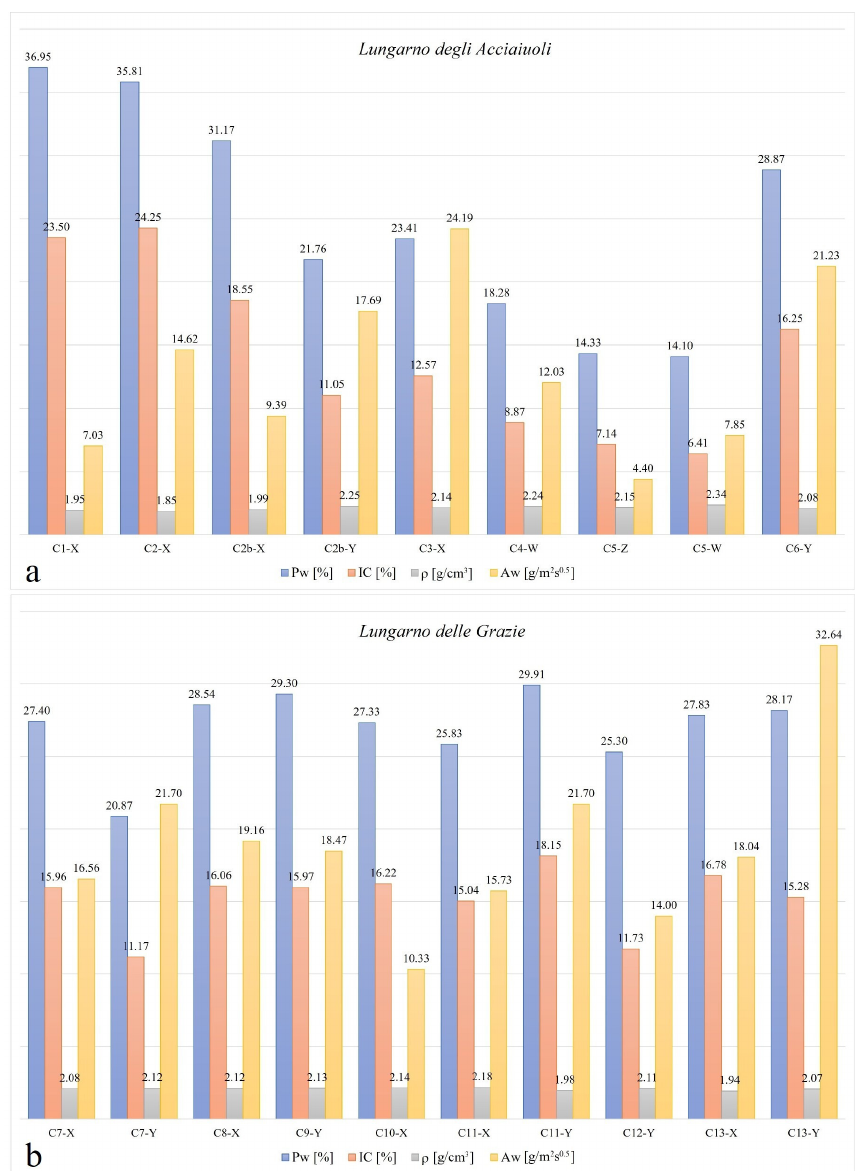
Figure 8. Results of physical analyses of test samples of Lungarno degli Acciaiuoli ( a ) and Lungarno delle Grazie ( b ). The values reported are effective porosity (Pw%, or porosity accessible to the water), total imbibition coefficient (IC%), density ( ρ ), and capillary water absorption coefficient (Aw). In Lungarno degli Acciaiuoli the X type, defined as “mortar with decimetric-sized